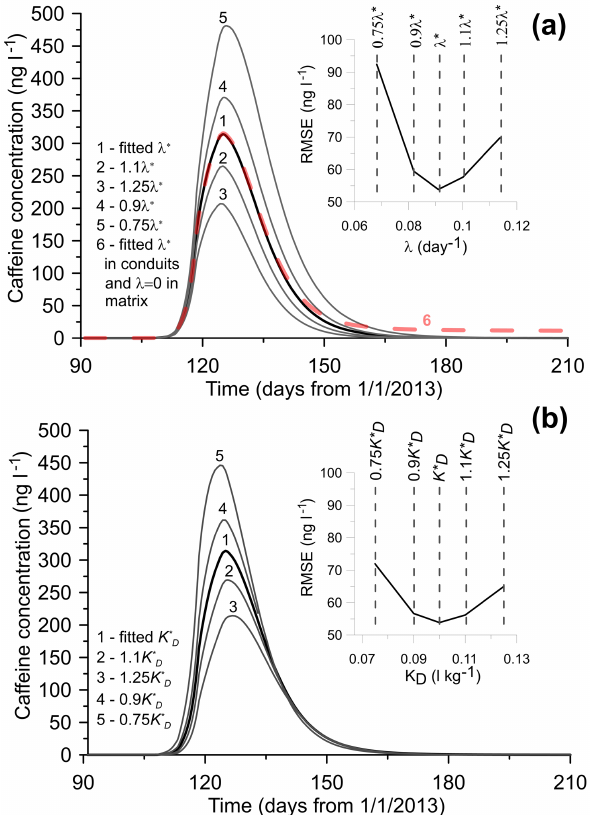
Figure 5. Simulated CAF sensitivity to parameters changes (a) the degradation rate and (b) the distribution coefficient. The insets show the effect of parameters on